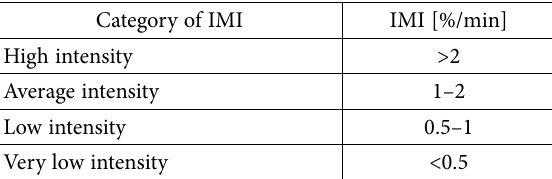
Table 3. Categories of IMI (Bulevičius et al.